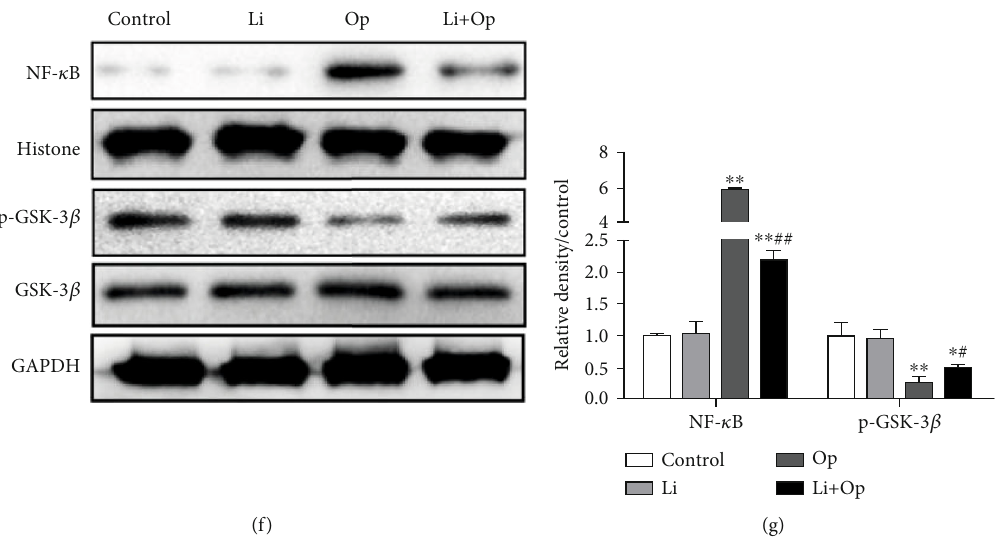
Figure 3: Inhibition of GSK-3 β suppresses tibial surgery-induced microglial activation and in fl ammatory response. (a) Representative images of immunohistochemical staining of microglia in the CA1 area of the hippocampus. (b, c) Quanti fi cation of Iba1-positive cells in the CA1 area of the hippocampus. (d, e) Levels of the TNF- α and IL-1 β proteins in the hippocampus were determined using ELISAs. (f) Levels of NF- κ B and p-GSK-3 β in the rat hippocampus were detected using Western blotting with speci fi c antibodies. (g) The levels of proteins were quanti fi ed by ImageJ, and the levels of p-GSK-3 β and NF- κ B were normalized to GSK-3 β or histone levels (p-GSK-3 β /GSK-3 β ratio and NF- κ B/histone ratio). Each value was then presented relative to the ratio of control, which was set to 1. The data are presented as means ± s : e : m : ( n = 3 ). ∗ P < 0 : 05 and ∗∗ P < 0 : 01 compared with the control group. # P < 0 : 05 and ## P < 0 : 01 compared with the OP